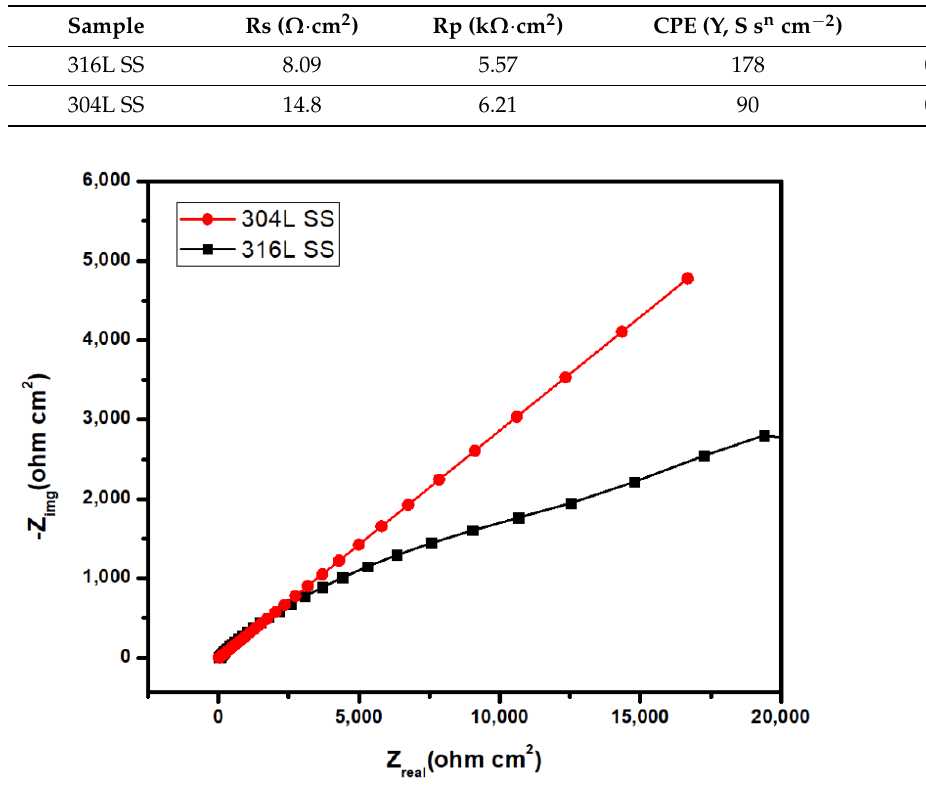
Figure 8. Nyquist plot of the 316L SS and the 304L SS in 3.5% NaCl solution. Table 3. EIS data of the 316L SS and the 304L SS in 3.5% NaCl solution.